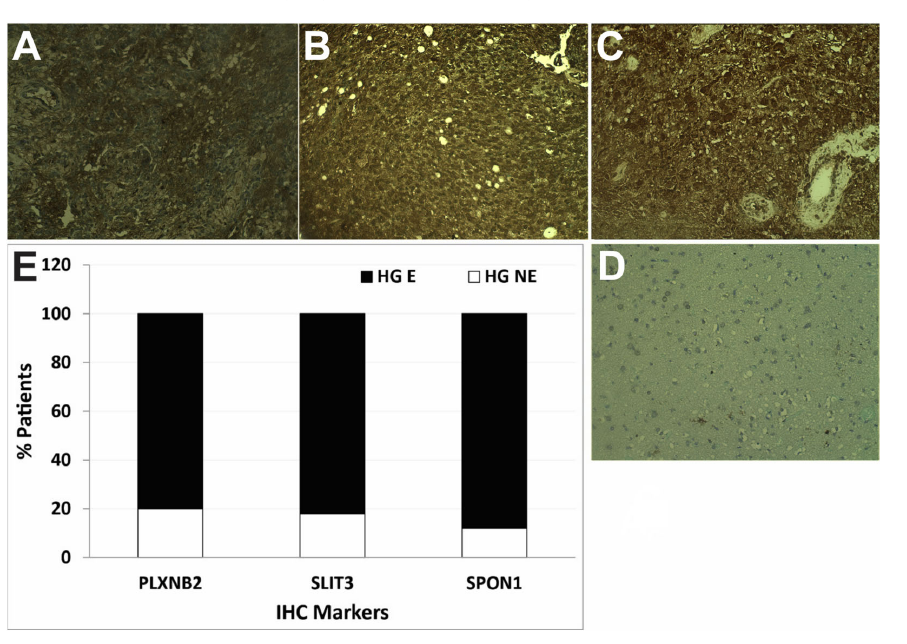
Figure 1. Expressions of PLXNB2, SLIT3, and SPON1 in human high ‐ grade gliomas. Representative immunohistochemistry (IHC) images for PLXNB2 ( A ), SLIT3 ( B ), and SPON1 ( C ) in human GBM tumor sections. ( D ) Negative control in a low ‐ grade glioma for SLIT3. Magnification is 20× for slides in ( A – D ). ( E ) Percentage (%) of patient protein expression (IHC) for PLXNB2, SLIT3, and SPON1 in high ‐ grade (HG) gliomas highly expressed (HG E) or not expressed (HG NE). The % of patient expression for each biomarker in HG was 80% or higher.